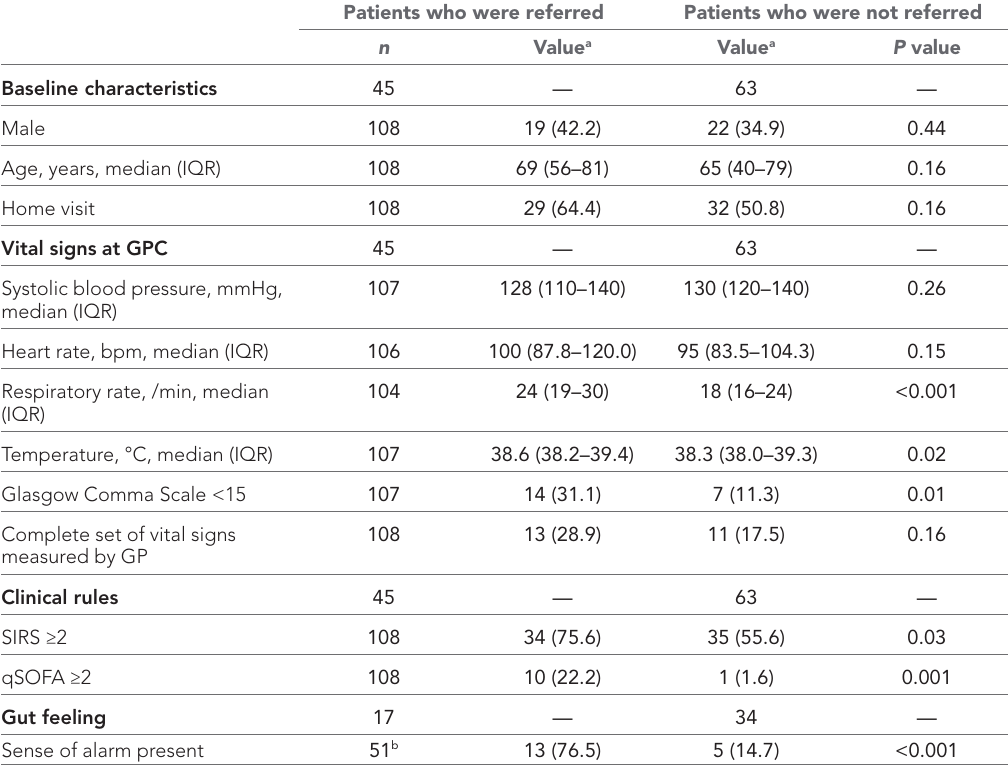
Table 3 Comparison between patients who were referred and patients who were not referred Patients who were referred Patients who were not